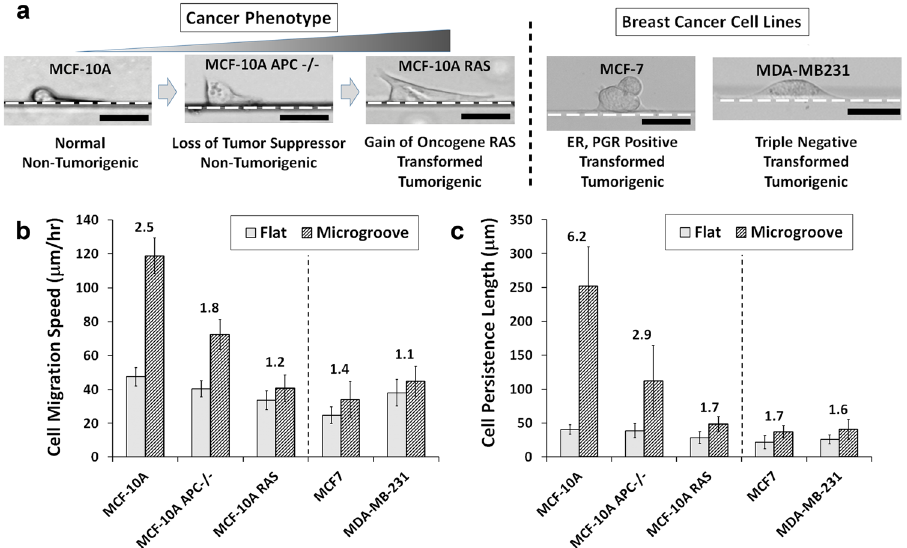
Figure 4. ( a ) Bright-field images of the disruption in the stable morphology with genetic alterations to the MCF-10A cells and morphologies of other breast tumor cell lines at the corners of the microgroove structures. Dotted lines represent the microgroove wall boundaries. (Scale bar, 20 μ m) ( b ) Speed and ( c ) persistence length measurements of MCF-10A variants and other breast tumor cell lines on the flat surfaces and at the corners of the microgrooves. Numbers above the bars represent the quantitative effect of topography as the ratio between the groove and flat measurements. Error bars are SEM (N = 5 trials with 10–20 cells quantified per